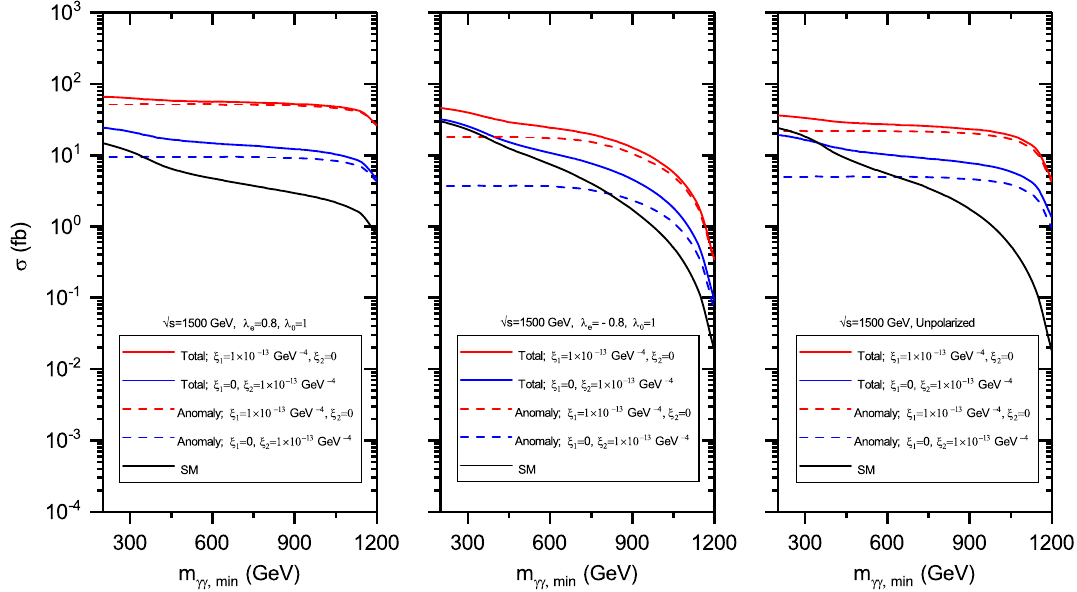
Fig. 4 The total cross sections for the process γγ → γγ as func- respectively. The curves on each plot (from the top downwards) are: the tions of the minimal invariant mass of the outgoing photons for the total cross sections for the coupling sets ( ζ 1 = 10 − 13 GeV − 4 , ζ 2 = 0) √ e + e − collider energy s = 1500 GeV. The left, middle and right pan- and ( ζ 1 = 0, ζ 2 = 10 − 13 GeV − 4 ), the anomalous contribution for the els correspond to the electron beam helicitiy λ e = 0 . 8 , − 0 . 8, and 0, same coupling values, the SM cross section